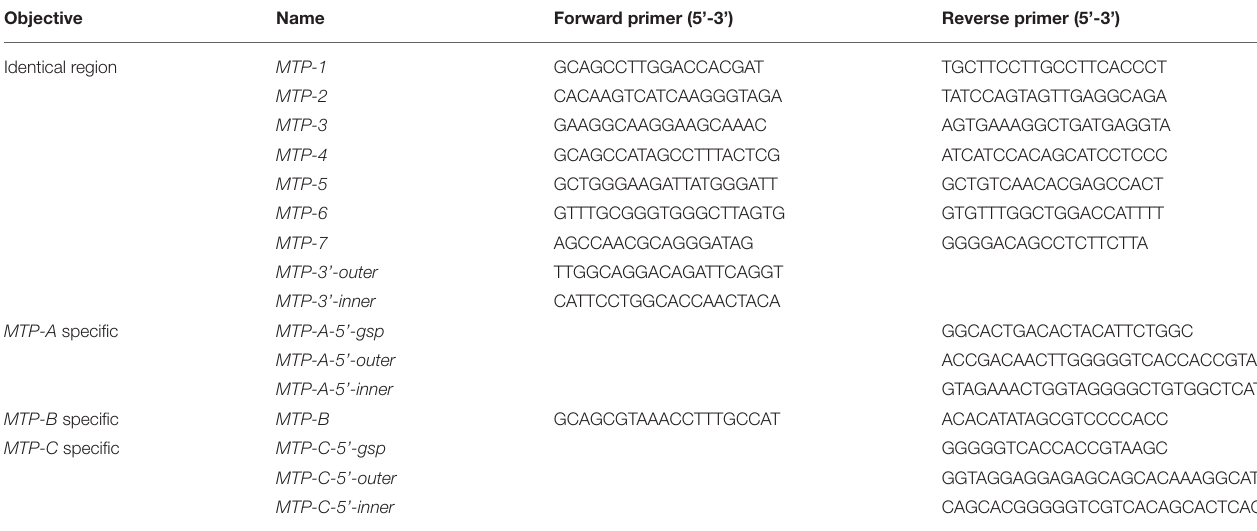
TABLE 2 | Primers used for MTP cloning in the present